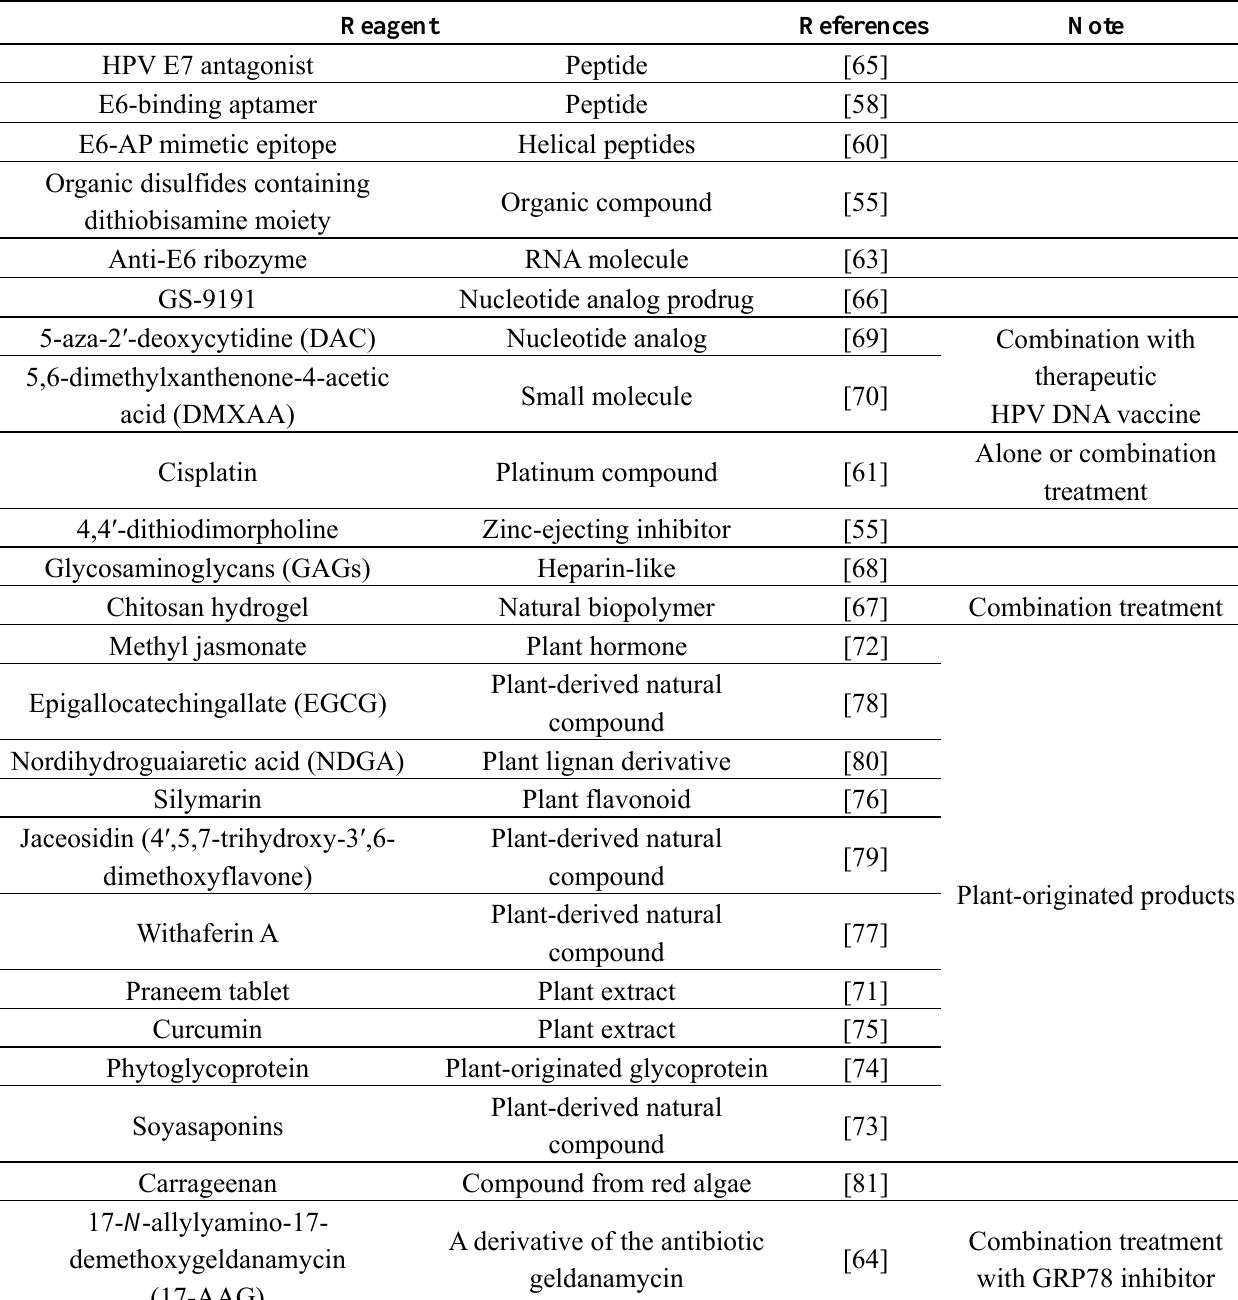
Table 1. HPV-targeting